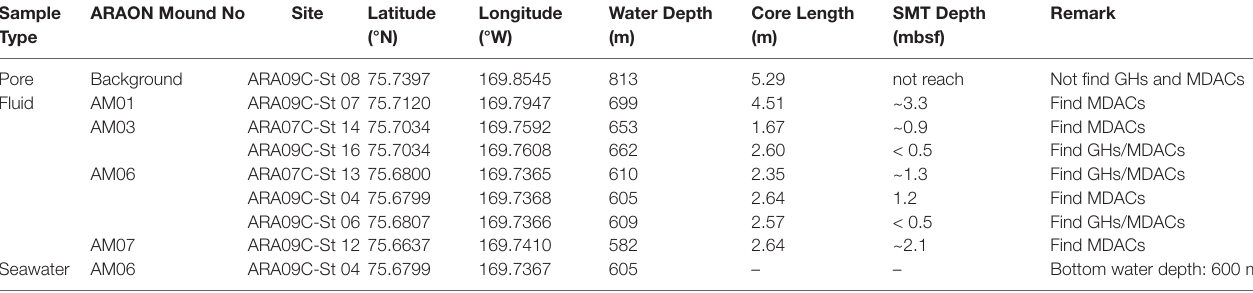
TABLE 1 | Summaries of location, water depth, core length, and SMT depth in each site from the ARA07C and ARA09C Expeditions.